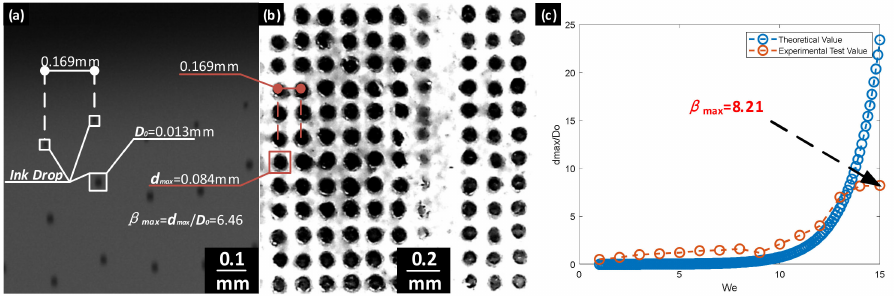
Figure 7. ( a ) The printing process from the arrayed nozzle recorded by the camera; ( b ) droplets deposited on the substrate; and ( c ) theoretical calculation and actual measurement